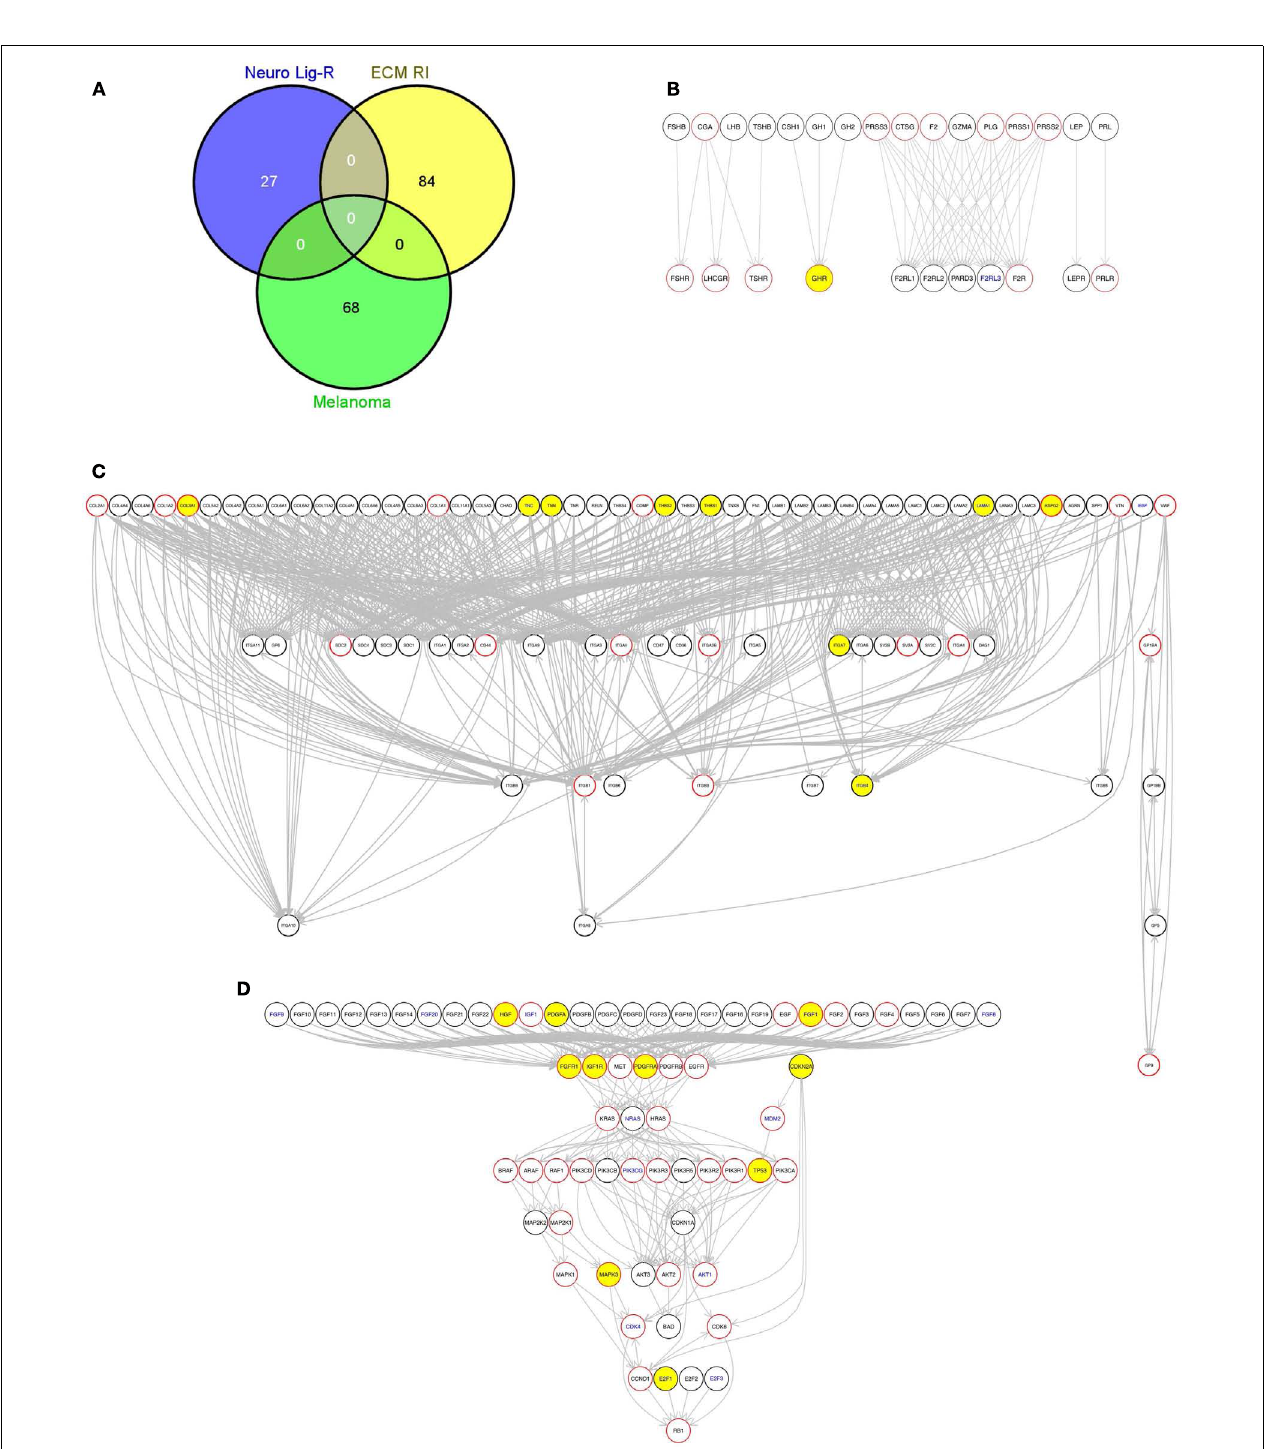
protein-altering somatic variations in this sample. Nodes with red borders represent genes that encode targets of existing drugs according to version 3 of the DrugBank database. Nodes with blue text indicate genes that encode RNAs with a significant association between expression and patient survival [ p ≤ 0.05 no multiple testing correction applied, Cox proportion hazards model, Bogunovic et al. (50) data, see Materials and Methods].This graph was generated using the pathwayGraph function and KEGG information contained within the R graphite package. Similar graphs can also be generated using the MelanomaDB web